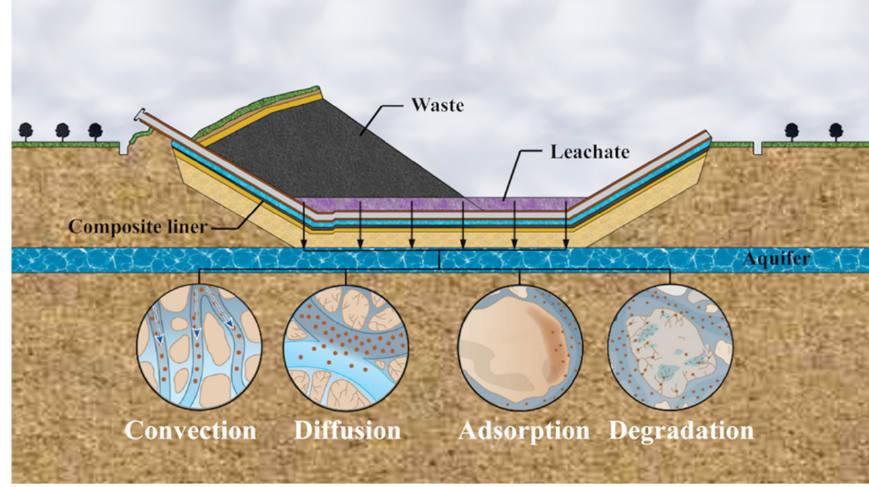
Figure 1. Schematic diagram of GM/GCL/AL (geomembrane/geosynthetic clay liner/attenuation layer) triple-layer liners.